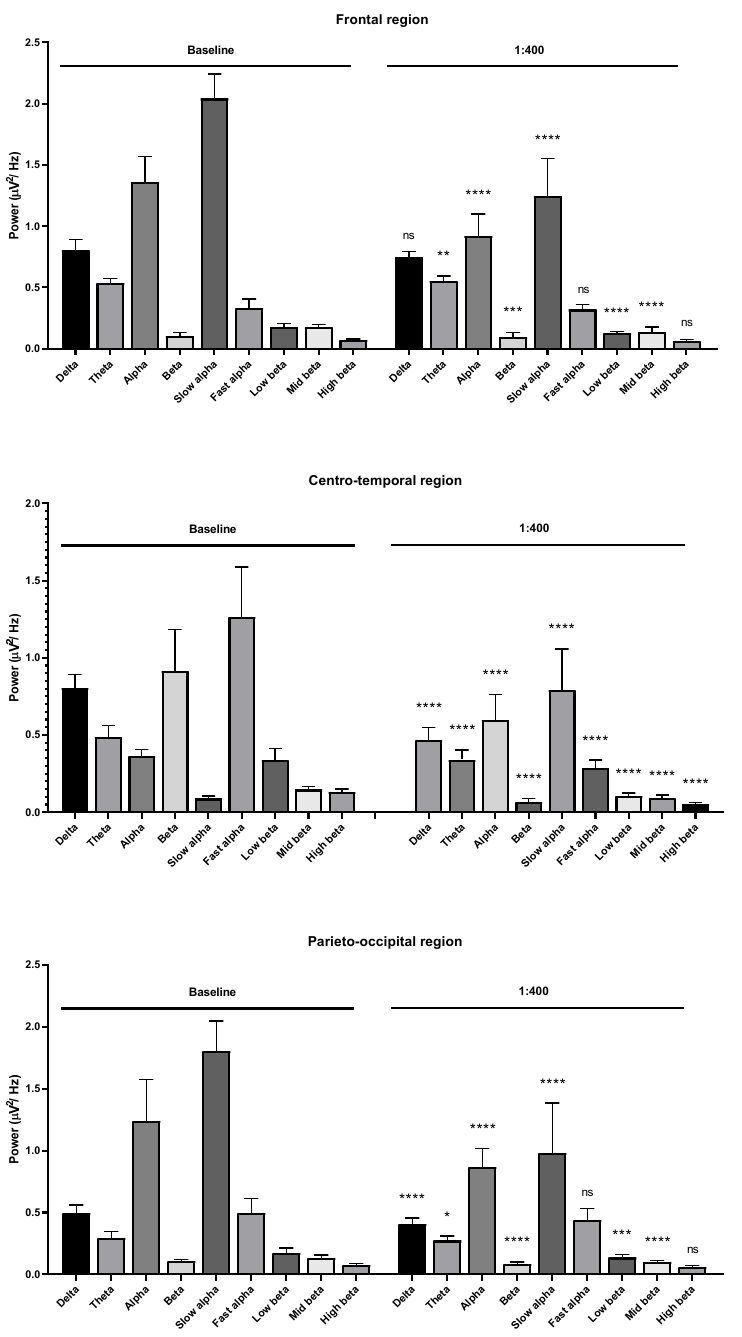
Figure 3. Effects of Litsea cubeba oil inhalation at a 1:400 dilution on the delta, theta, alpha, beta, slow alpha, fast alpha, low beta, mid beta, and high beta wave powers: ( upper ) frontal region; ( middle ) centro-temporal region; ( lower ) parieto-occipital region. p value: not significant (ns) ≥ 0.05, * < 0.05, ** < 0.01, *** < 0.001, and **** < 0.0001.